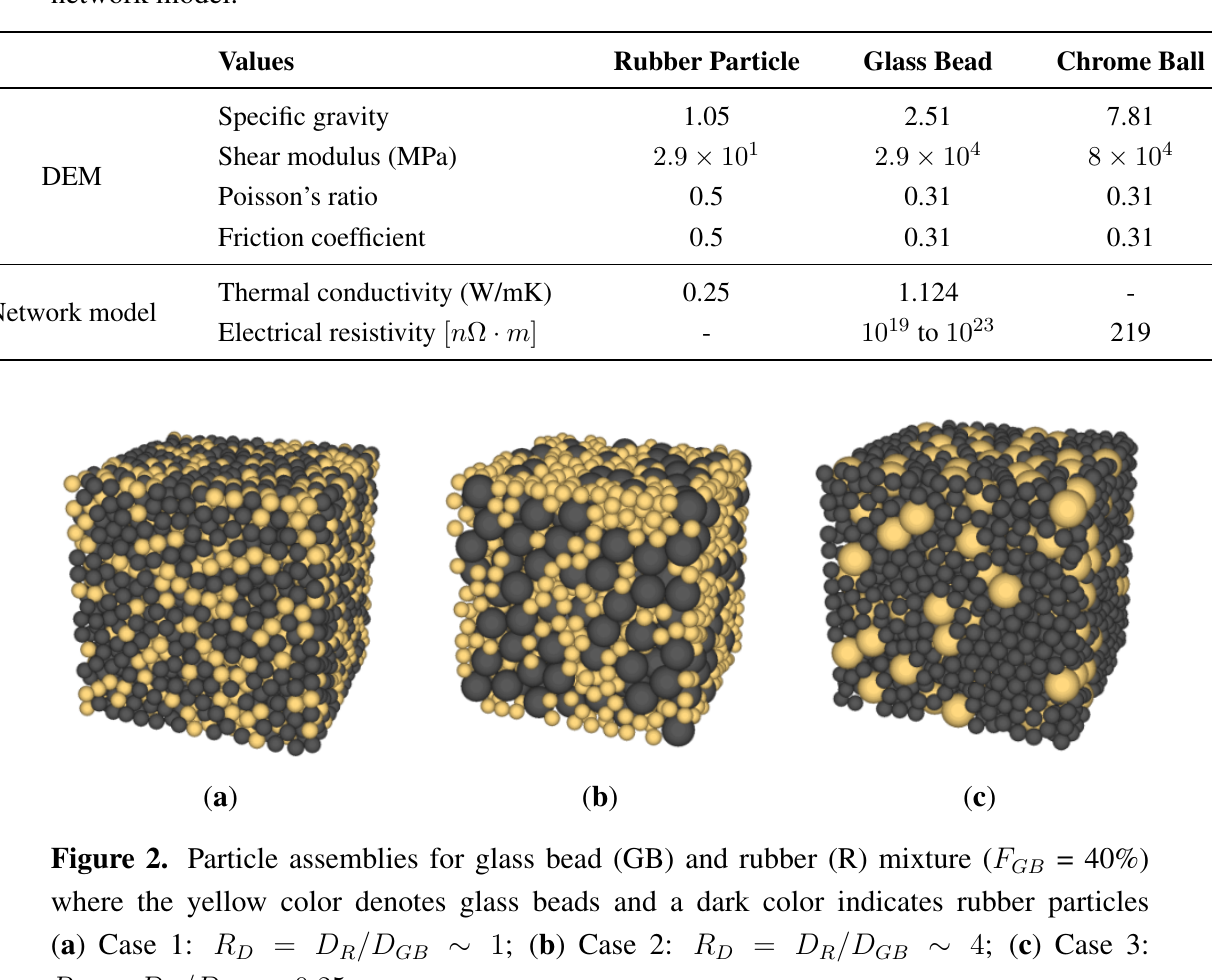
= 40%) GB = D /D ∼ 4 ; ( c ) Case 3: D R GB